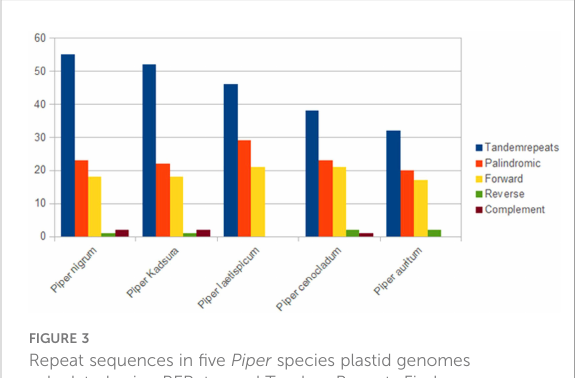
FIGURE 3 Repeat sequences in fi ve Piper species plastid genomes calculated using REPuter and Tandem Repeats